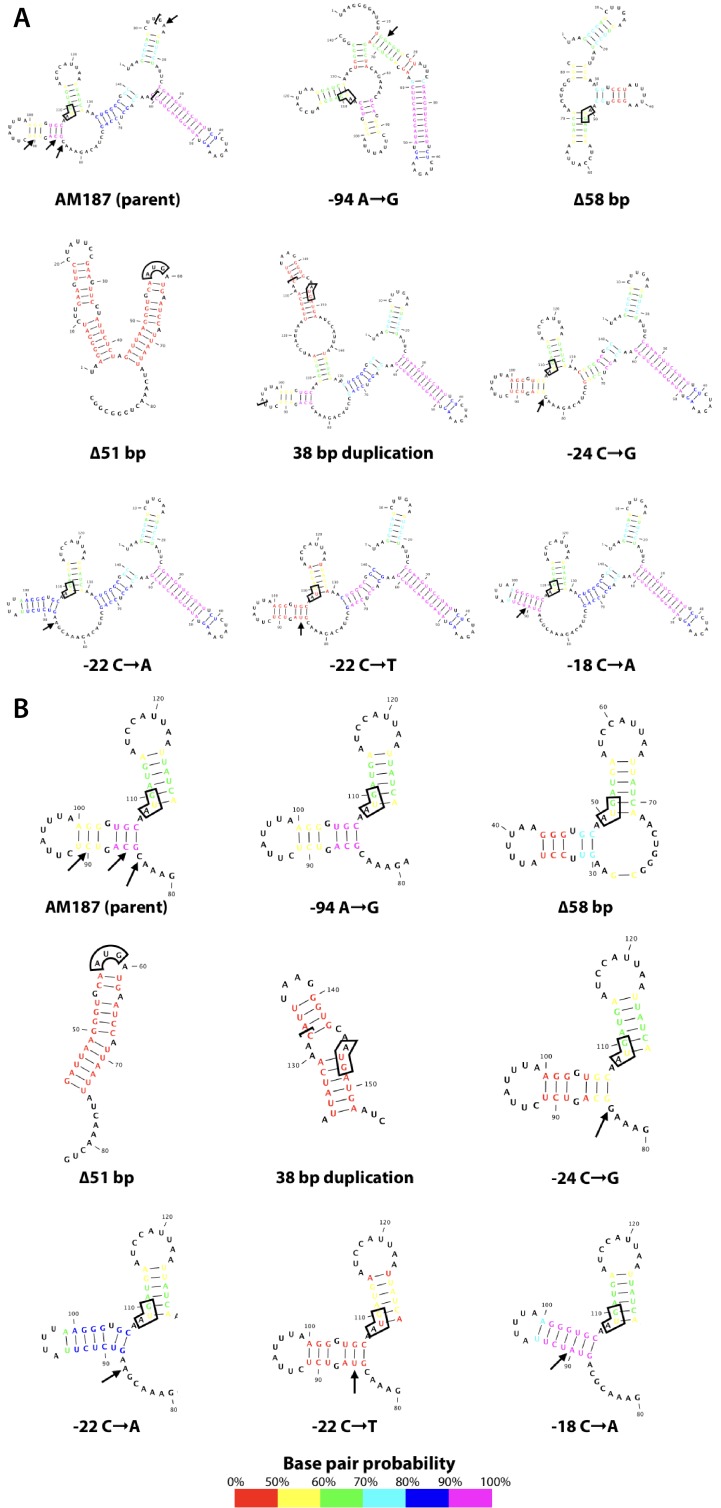
argB mRNA secondary structure comparison.(A) The entire intergenic region between kanr and argB plus 33 nucleotides of the argB coding region was used for RNA structure prediction. The start codon for argB is boxed in each structure. Arrows in the AM187 and wild-type structure indicate locations of adaptive point mutations. Brackets in the AM187 structure contain the FLP recognition target (FRT) site. Brackets in the 38 bp duplication mutant structure contain the 38 inserted nucleotides. (B) Same as in (A), but showing only the region surrounding the argB start codon.